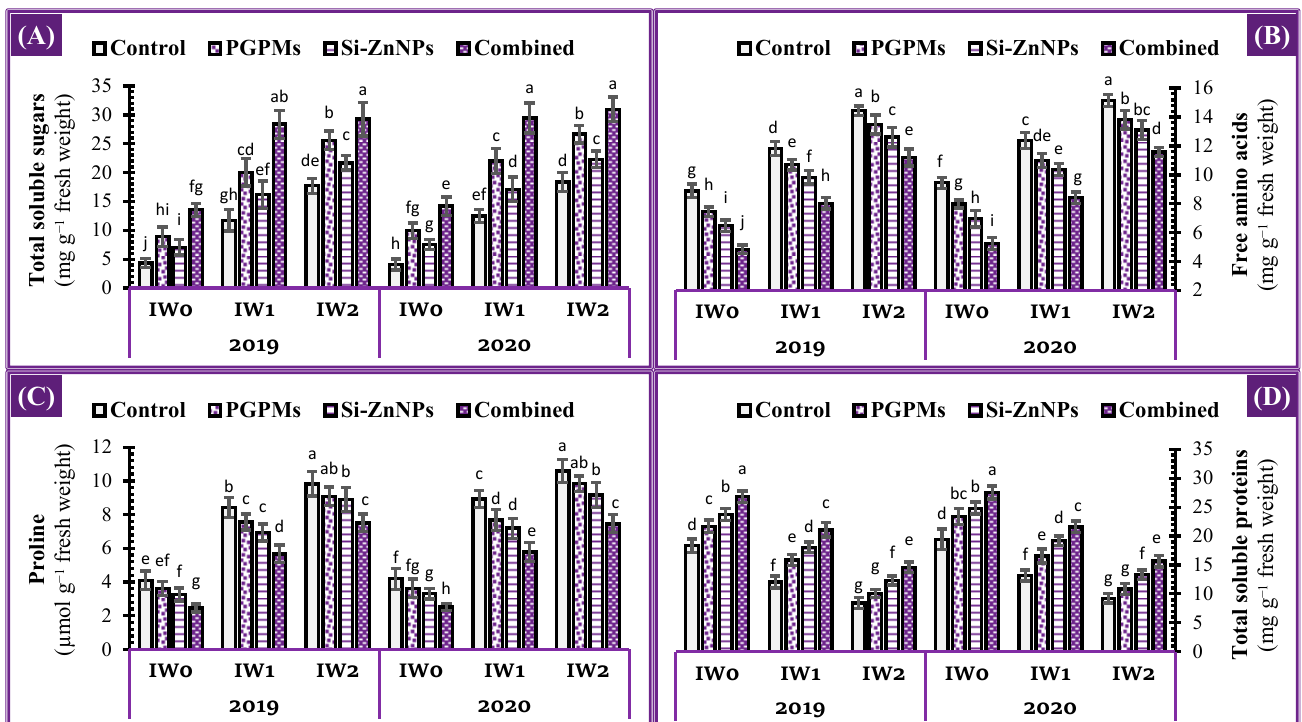
Figure 4. Influence of application of PGPMs, Si-ZnNPs and their combination on the concentration of ( A ) total soluble sugar, ( B ) free amino acids, ( C ) proline, and ( D ) total soluble proteins in the leaves of soybean plant grown in salt-affected soil with different levels of watering intervals ( IW 0 ; 11 days, IW 1 ; 15 days, and IW 2 ; 19 days) during the successive 2019 and 2020 growing seasons. The data presented as means ± SD. Means labeled with the same lower-case letter are not significantly different according to Duncan’s Multiple Range Test.